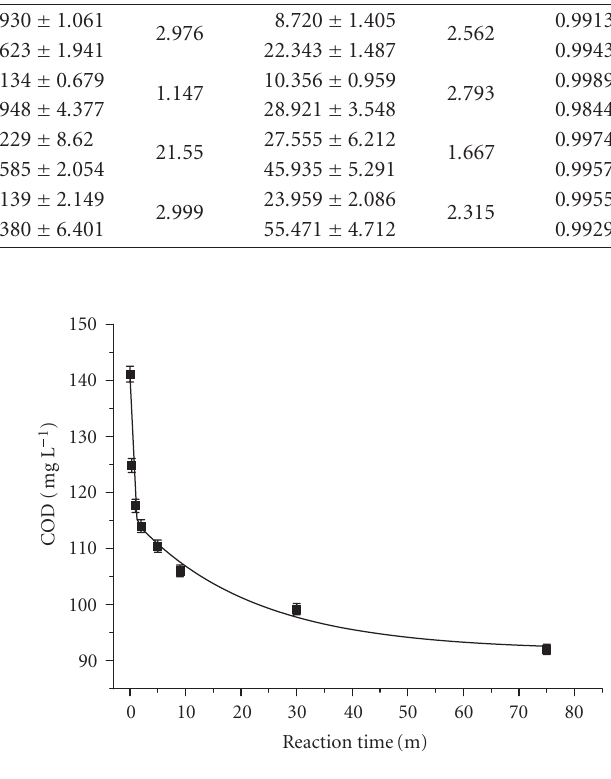
Figure 3: COD abatement of a solution 0 . 289 mmol L − 1 atrazine as a function of solar irradiation time. ( (cid:2) ) corresponds to the exper- imental data. (—) corresponds to a plot obtained from the best fit of the experimental data using the exponential decay second-order equation.